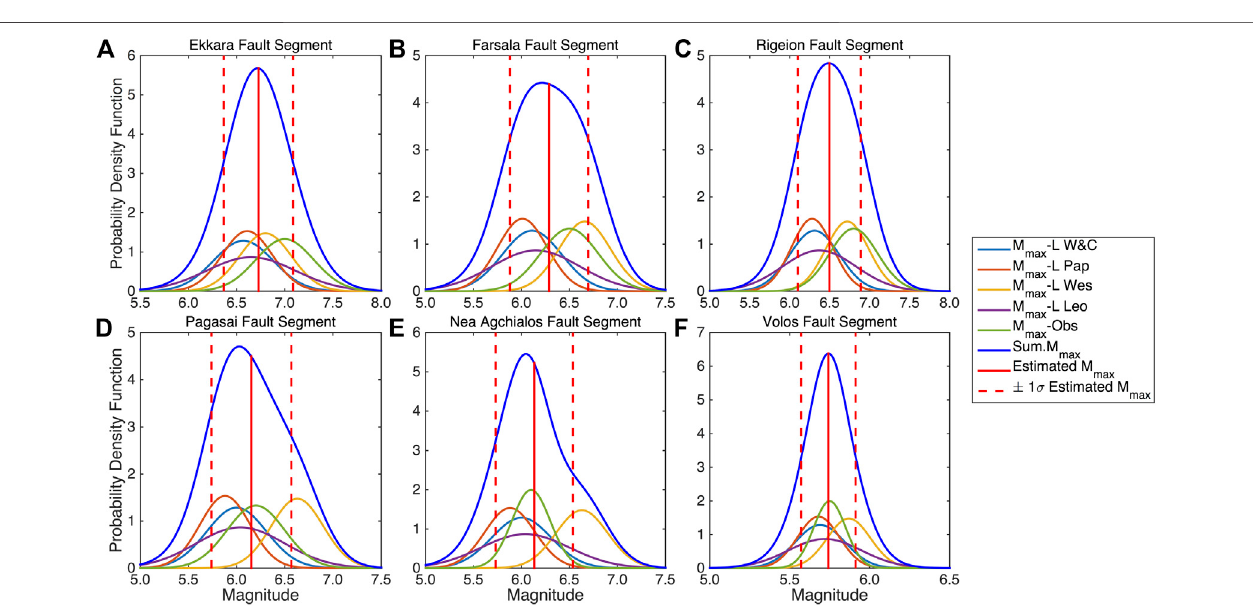
FIGURE 2 | Probability density functions considering the normal distribution with mean value and standard deviation, the estimated M max , and its corresponding ± 1 σ as resulted from the (Wells and Coppersmith, 1994; light blue lines), (Papazachos et al., 2004; orange lines), (Wesnousky, 2008; yellow lines), and (Leonard 2010; magenta lines) scaling relations for normal faults using the fault segment length as input for each of the six segments of the Southern Thessaly Fault Zone. The green curves represent the normal distribution accrued from the observed M max and its ± 1 σ based on the past strong earthquakes that occurred per segment. Blue curves depict the summed probability functions resulted from the combination of both scaling densities, along with the observational ones. The central values and their corresponding ± 1 σ of the summed densities after the application of the Gaussian fi t are shown with solid and dashed red lines, respectively.